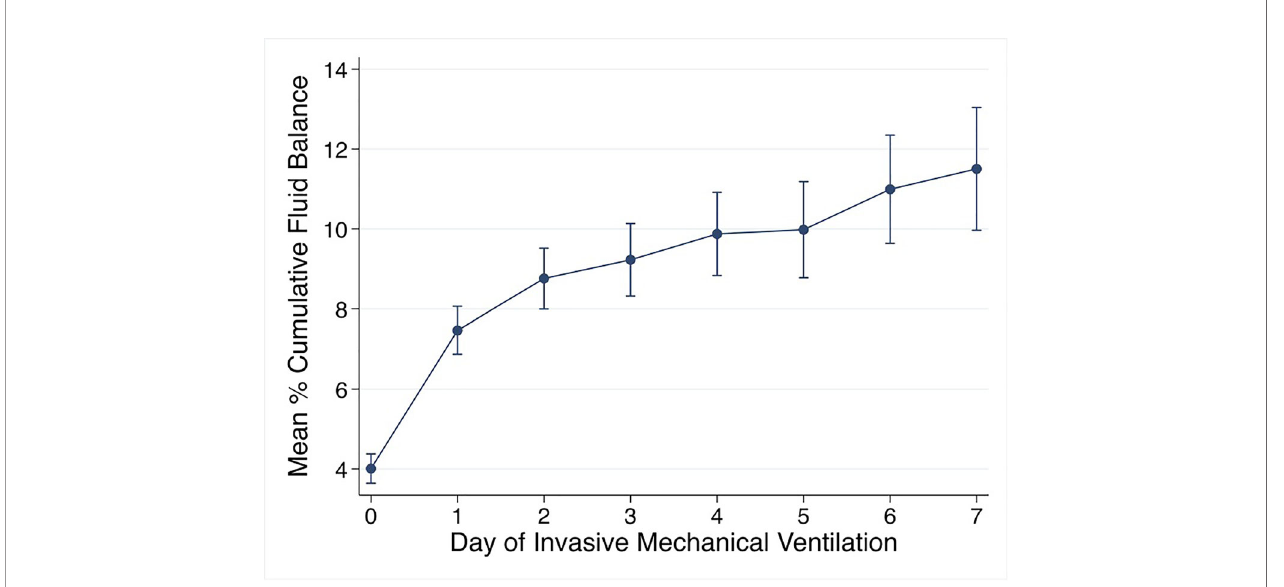
FIGURE 3 | Mean % cumulative fl uid balance by day of invasive mechanical ventilation. % cumulative fl uid balance =[Fluid in-Fluid out (liters)]/[PICU admission weight (kg)]